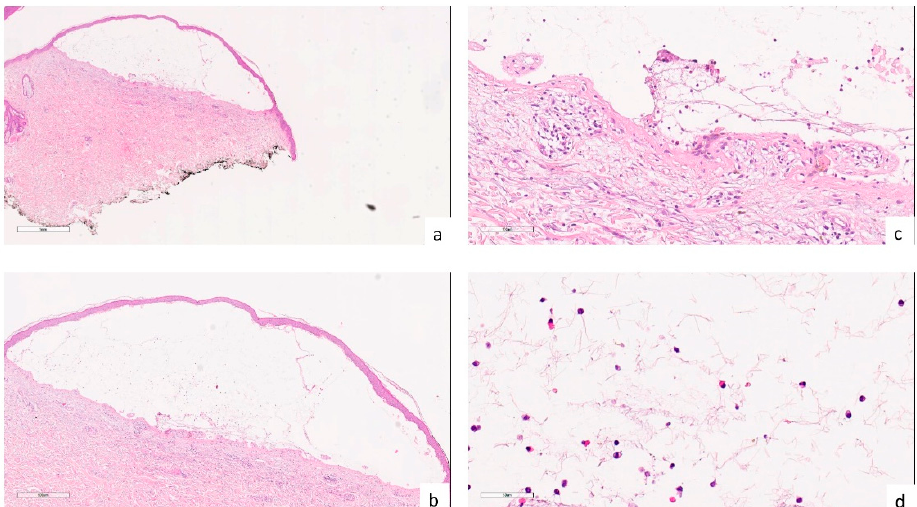
Figure 2. ( a , b ) Histologically, a subepidermal bullous lesion is observed (( a ) hematoxylin-eosin, 2×; ( b ) hematoxylin-eosin, 4×); ( c ) Drawing of the dermal papillae on the bulla floor (hematoxylin-eosin, 20×); ( d ) at higher magnification, the bulla content consisting of fibrin and a modest cellular component, including an appreciable proportion of eosinophils, is apparent (hematoxylin-eosin,